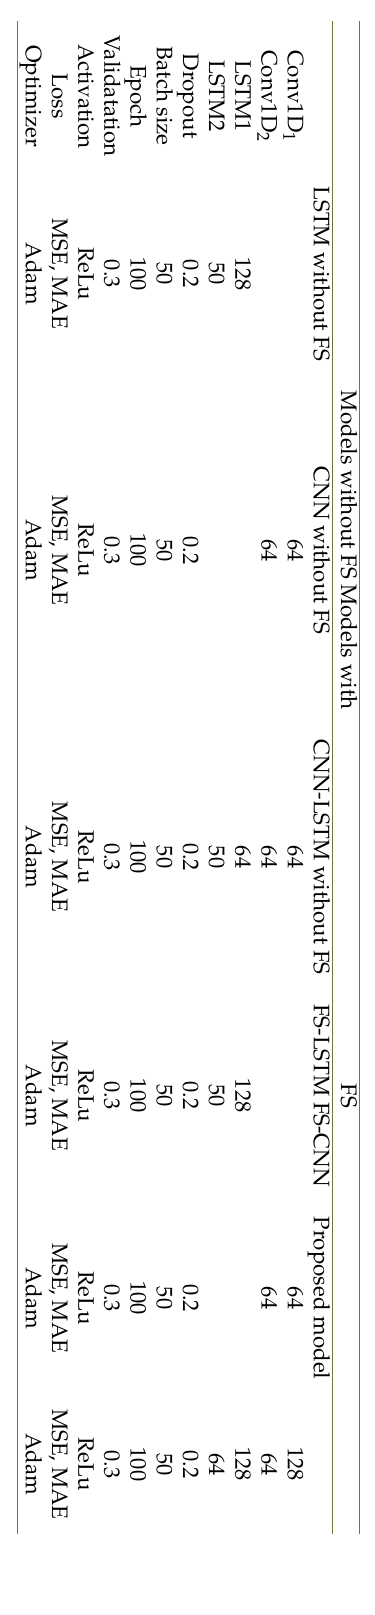
Fig. 6. Forecasting results comparison of 4 models. (a): in 240h; (b): in 24h.